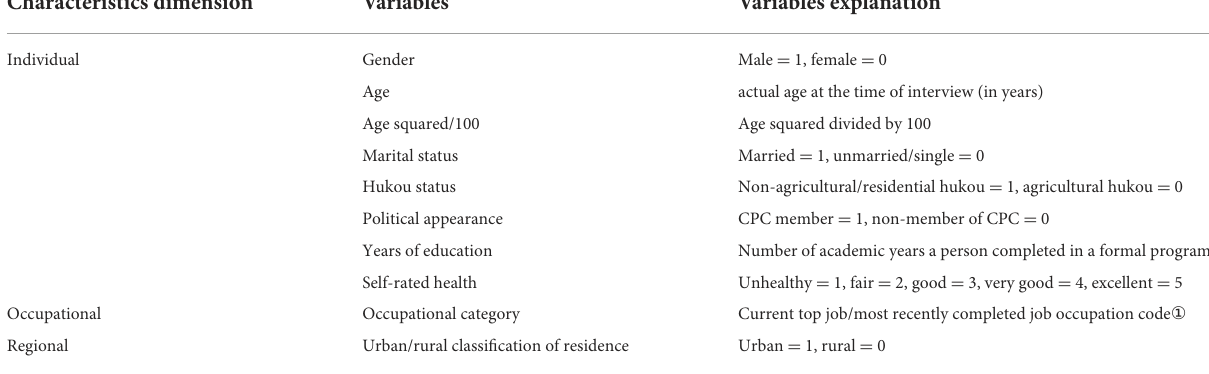
TABLE 1 Description of control